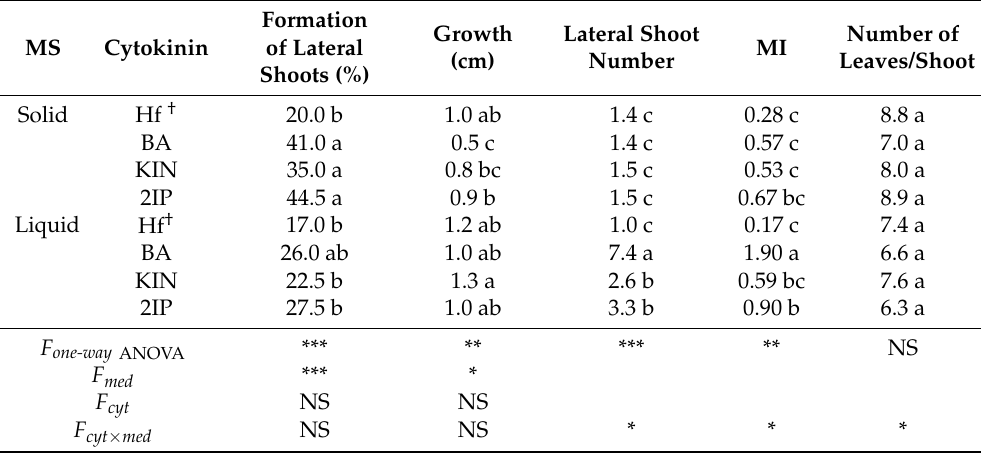
Table 4. Shoot proliferation from leaf-origin explants excised from shoots produced either on Hf MS medium or on MS containing BA at 0.5 or 1.0 mg L − 1 , on solid and liquid media containing BA, KIN or 2IP at 1.0 mg L − 1 or